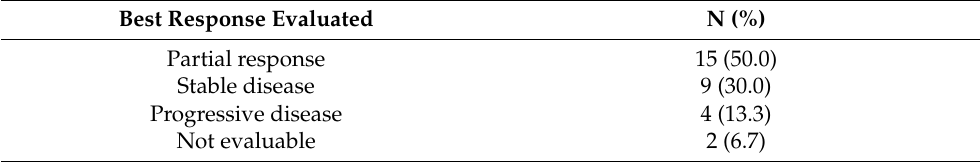
Table 3. Best therapeutic